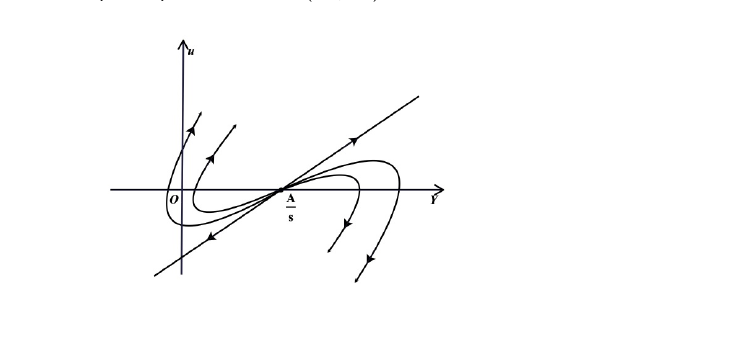
Fig. 5 Schematic diagrams of the differential structure model of economic adjustment under unstable